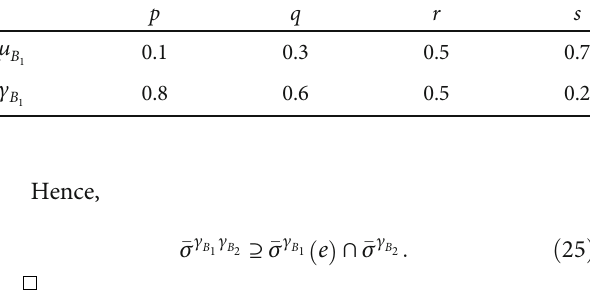
Table 22: Intuitionistic fuzzy set B